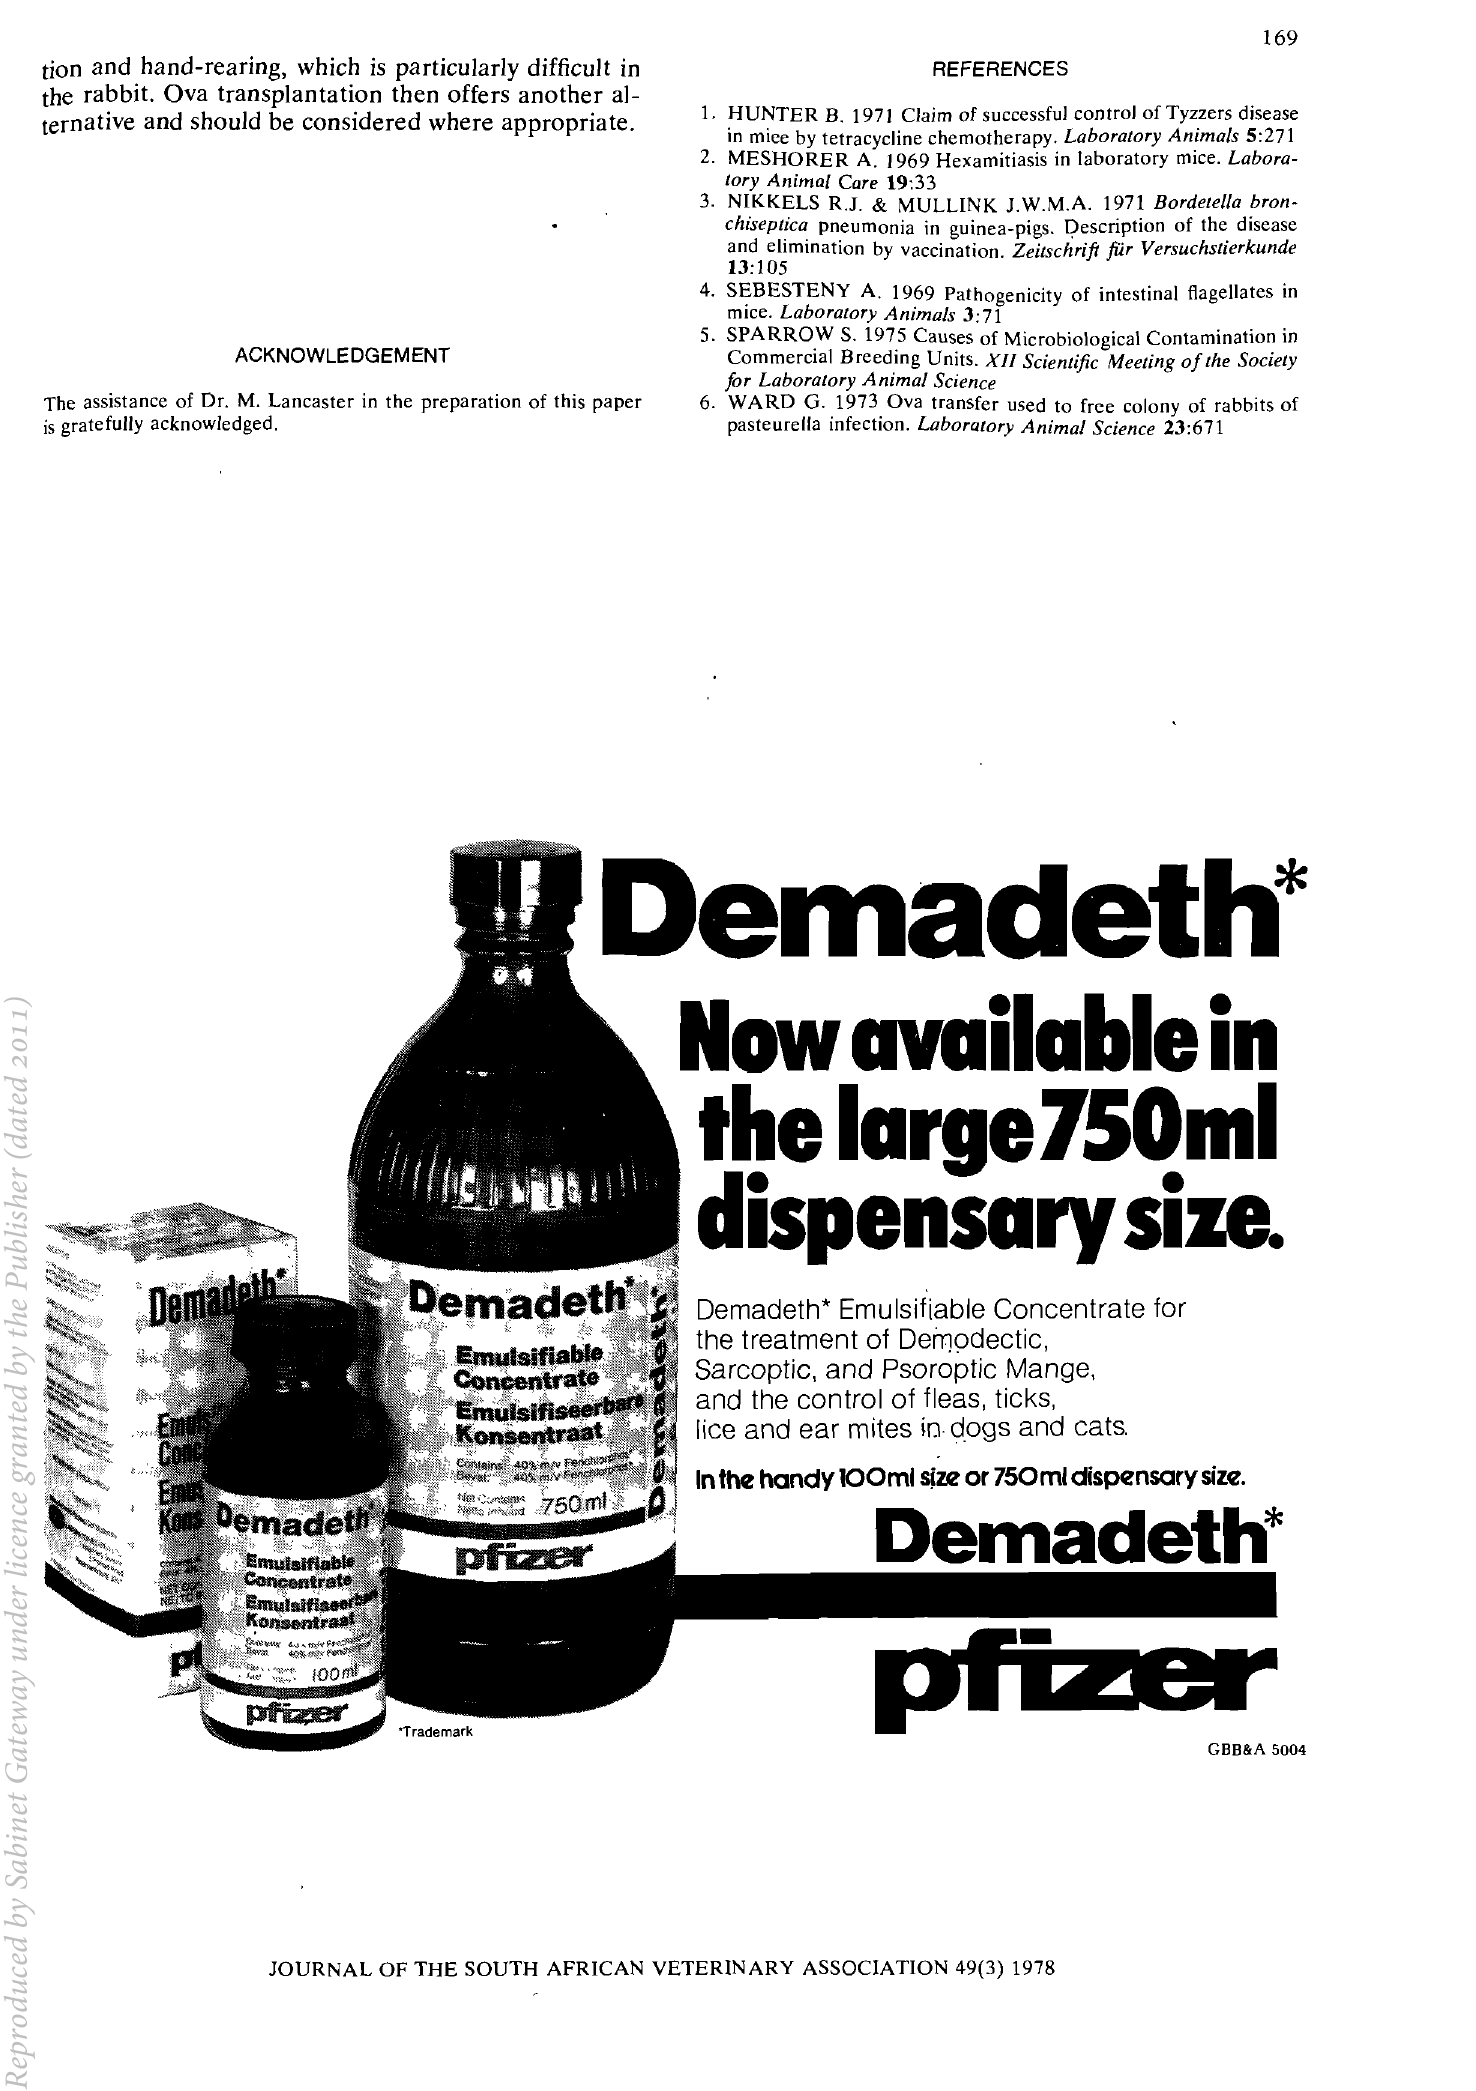
Demadeth* Emulsifiable Concentrate for the treatment of Dern9dectic, Sarcoptic, and Psoroptic Mange, and the control of fleas, ticks, lice and ear mites irJ dogs and cats. In thtl handy 100ml Size or 750ml dispensary